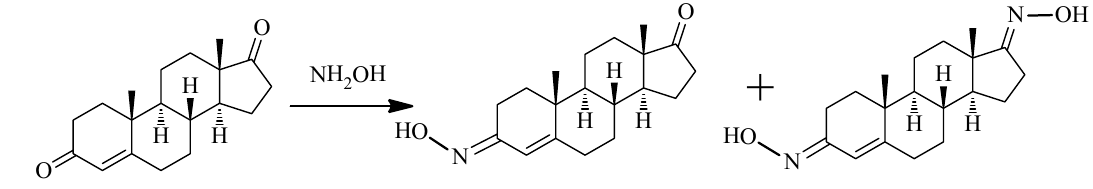
Fig. 6 The derivatization reaction of 4-androstenedione with